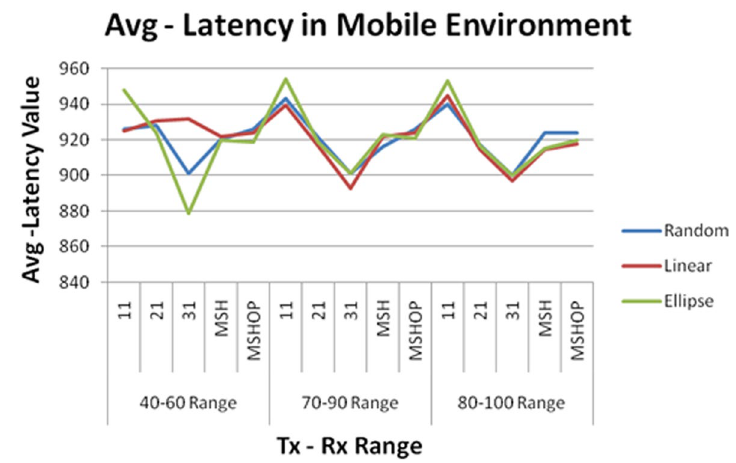
Fig. 26 Average latency in mobile